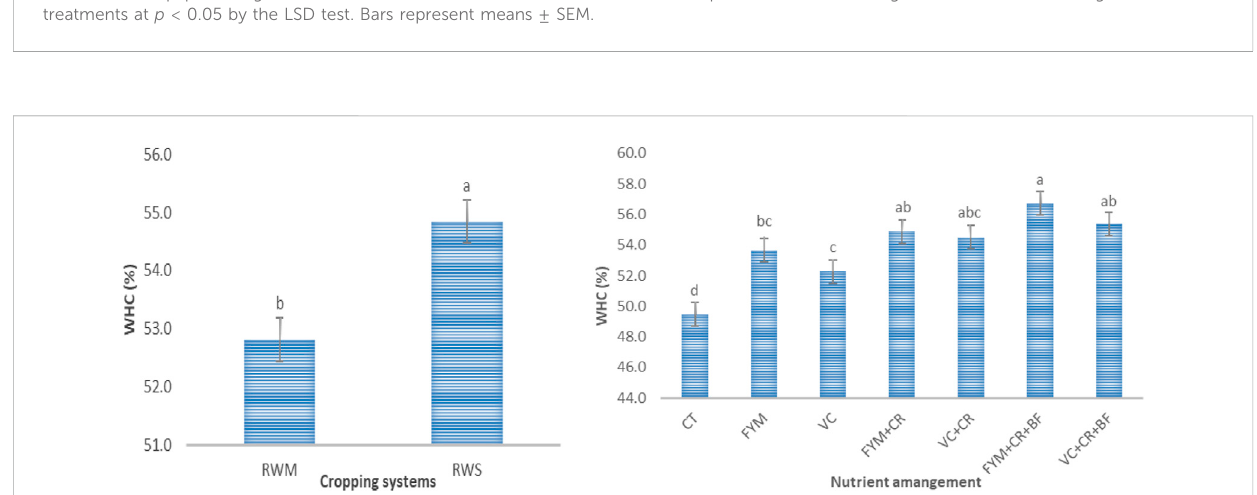
FIGURE 5 Long-term effect of cropping systems and organic nutrient management on WHC. WHC: water holding capacity; RWM: rice-wheat-mung bean; RWS: rice-wheat-sesbania; CT: control; FYM: farm yard manure; VC: vermicompost; CR: crop residue(s); and BF: biofertilizer(s). Statistical method: analysis of variance for strip-plot design in SAS 9.3 software; n = 42. Values with a different capital letter indicate a signi fi cant difference among the different treatments at p < 0.05 by the LSD test. Bars represent means ±